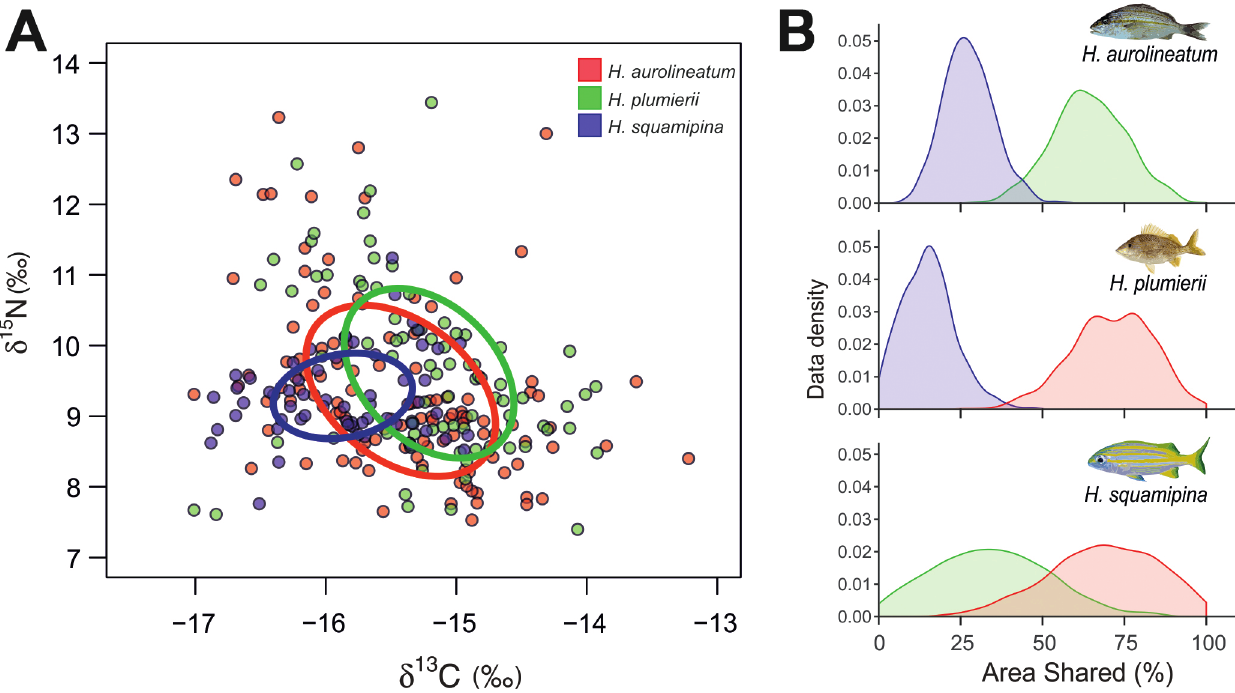
FIGURE 6 | A. Scaled isotopic niches and B. Isotopic overlap of Haemulon aurolineatum , H. plumierii and H. squamipina captured along the northeast coast of